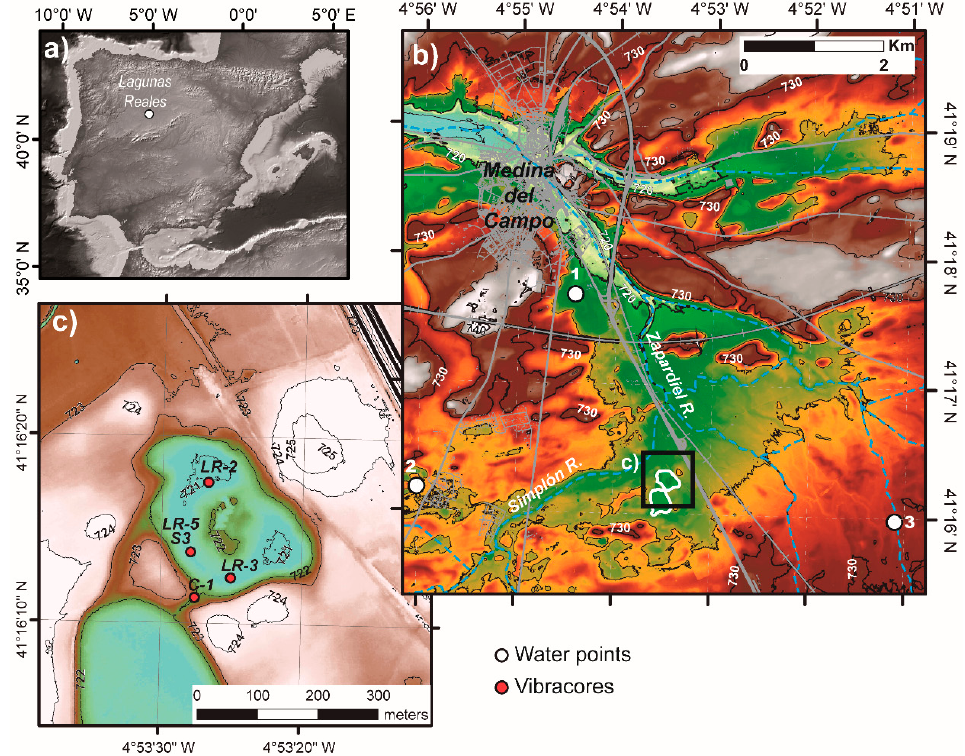
Figure 1. Location of the study area. ( a ) Location of the Lagunas Reales in the Iberian Peninsula. ( b ) Coloured digital elevation model showing the location of the wetland in relation to the Zapardiel and Simplón rivers. Black lines: 5 m contour lines. Water points: (1) 1517-4-002, (2) Balneario de Las Salinas and (3) N-64. ( c ) Location of studied cores (red dots) in the northern pond. Black lines: 1 m contour lines.